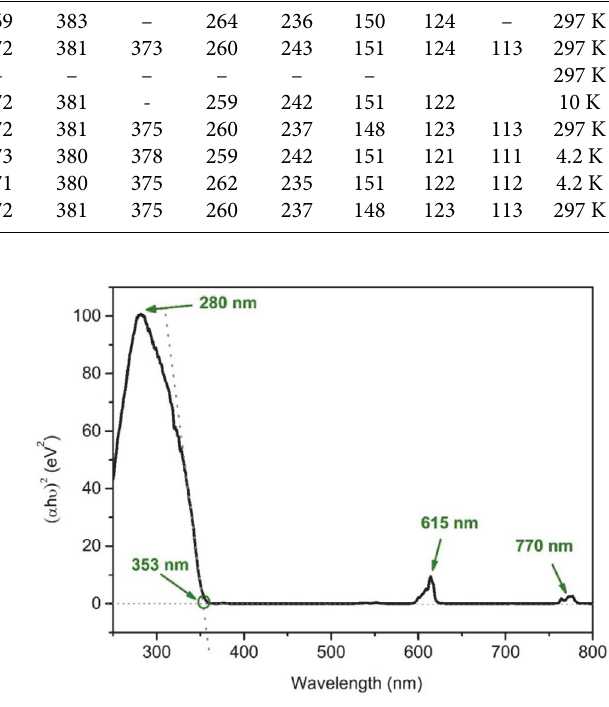
Fig. 6. The UV-Vis diffuse reflectance spectrum of the NdVO 4 nan- opowder prepared in this